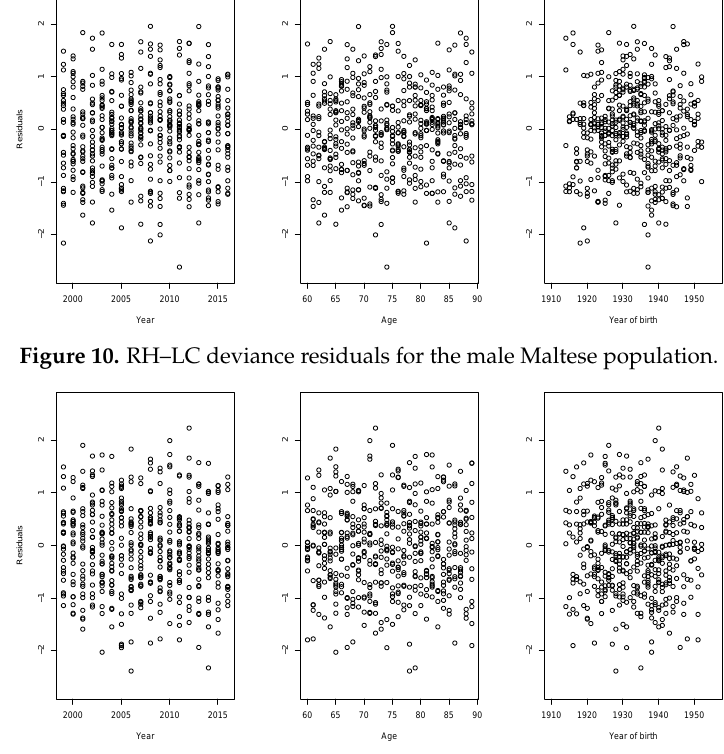
Figure 11. Plat–LC deviance residuals for the female Maltese